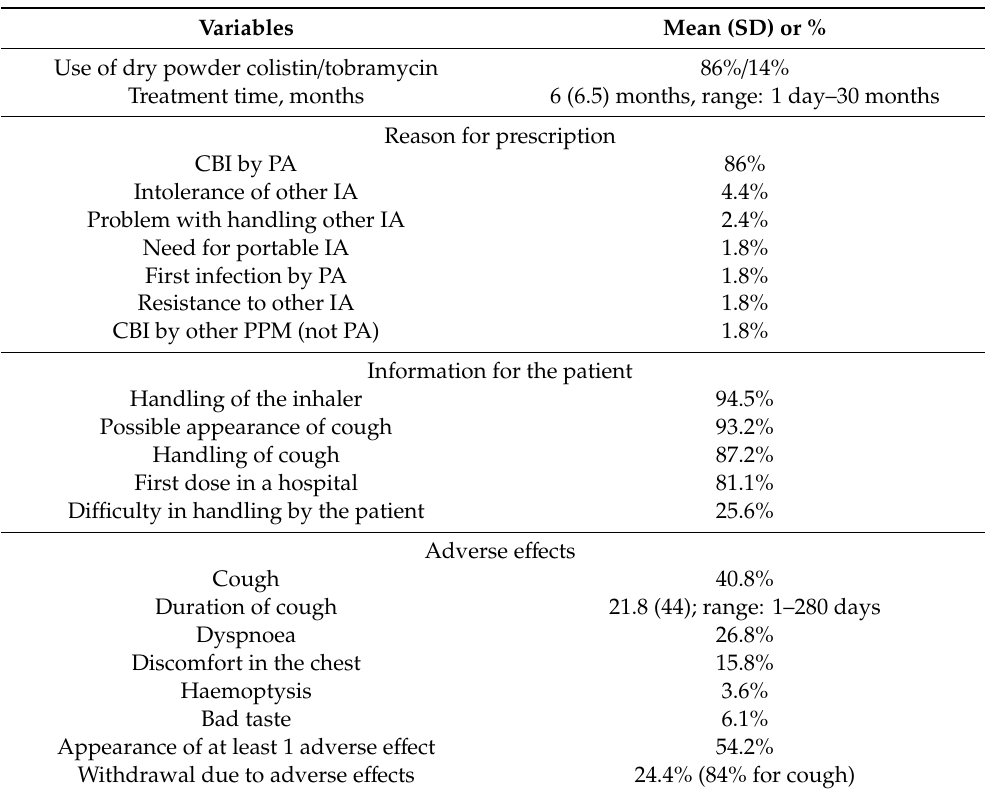
Table 3. Characteristics associated with the use of dry powder inhaled